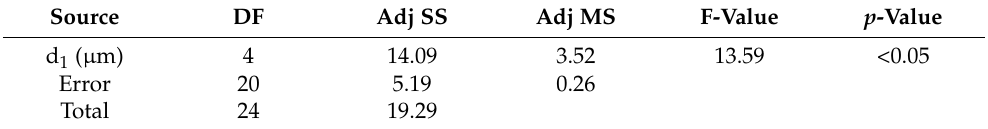
Table 5. ANOVA to test the influence of the diameter of the first particle (d 1 ) on the neck radius.